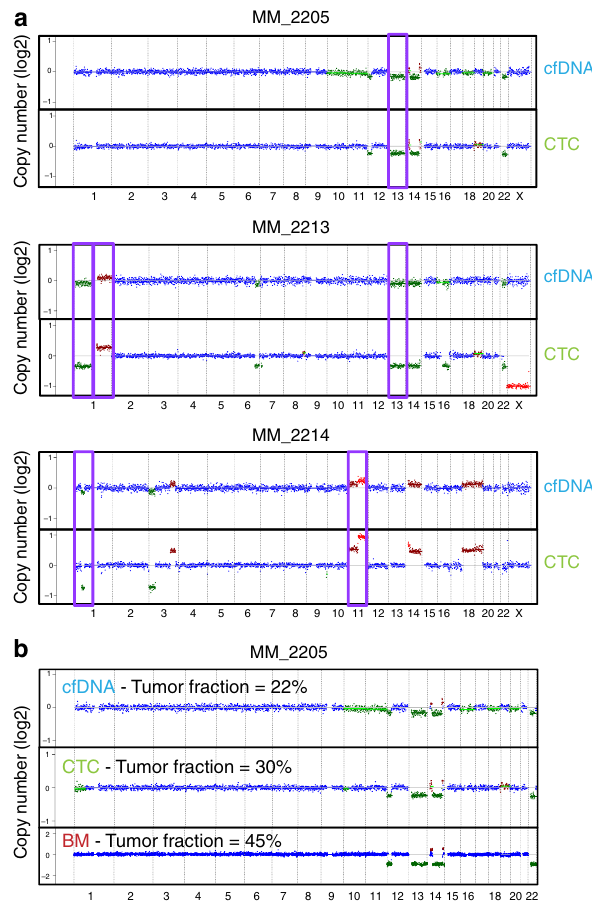
Fig. 4 Copy number alterations detection of CTCs and cfDNA in multiple myeloma. a MM-related copy number alterations (CNAs — purple box) were detected in three patients with matched cfDNA and CTC samples via ULP-WGS. Ampli fi cation (red), deletion (green), and copy neutral (blue) are indicated. b Comparison of normalized copy ratios (log2) among cfDNA ULP-WGS, CTC ULP-WGS, and tumor biopsy WES in MM_2205. Ampli fi cation (red), deletion (green), and copy neutral (blue) are